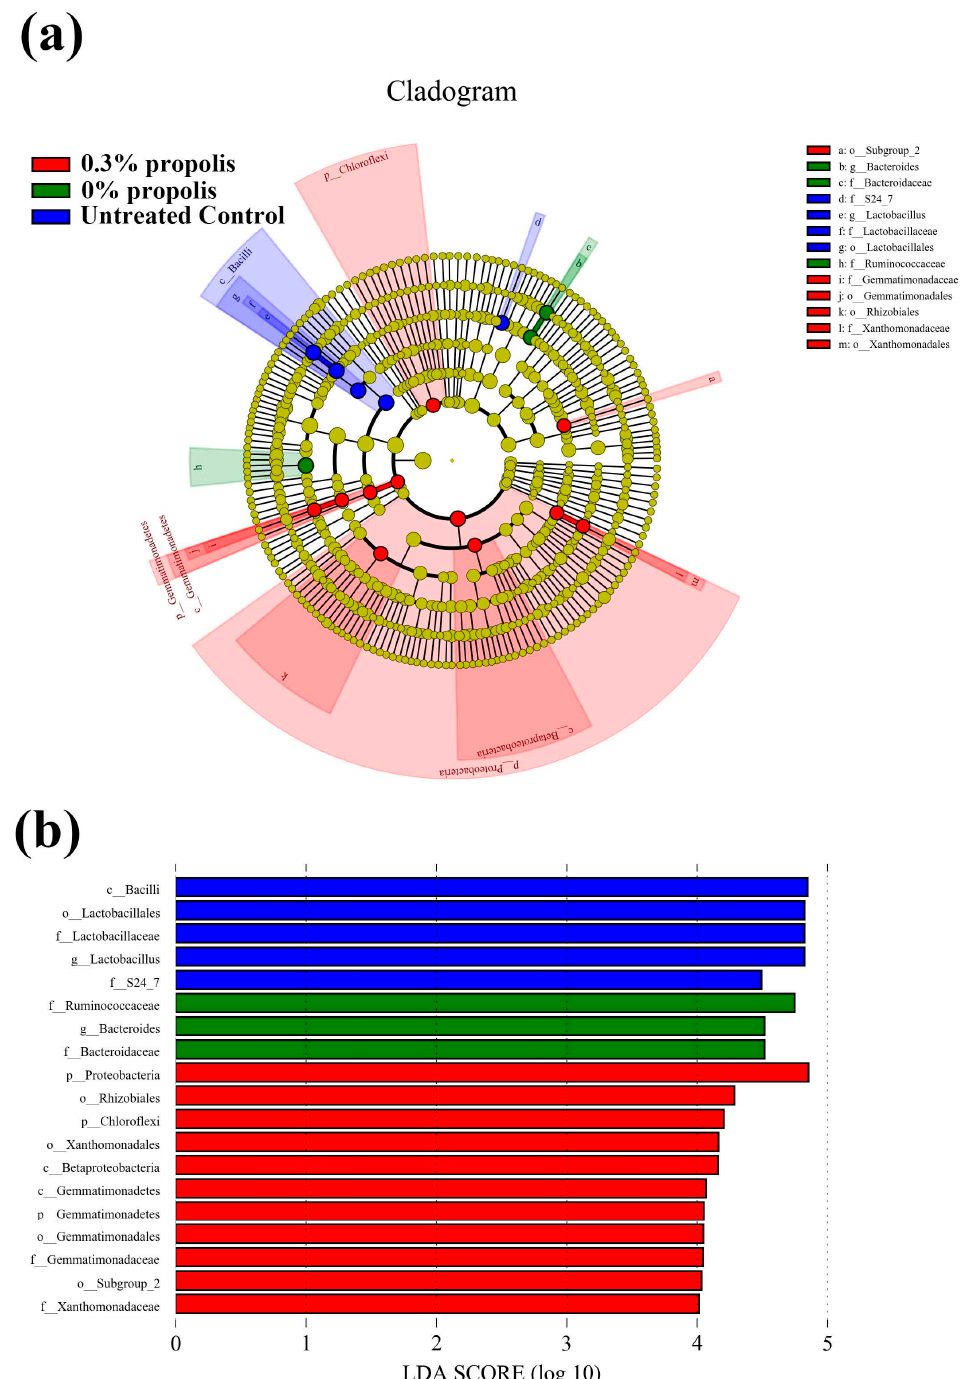
Figure 3. Characteristics of microbial community composition using LEfSe analysis. ( a ) Taxonomic cladogram obtained from LEfSe analysis of 16S rRNA sequencing. Red shaded areas indicate the 0.3% propolis supplement taxa; green shaded areas indicate the 0% propolis taxa and blue shaded indicate untreated control taxa; ( b ) Taxa value meeting a significant LDA threshold value of >4.0 are shown, which are displayed with a positive LDA score.